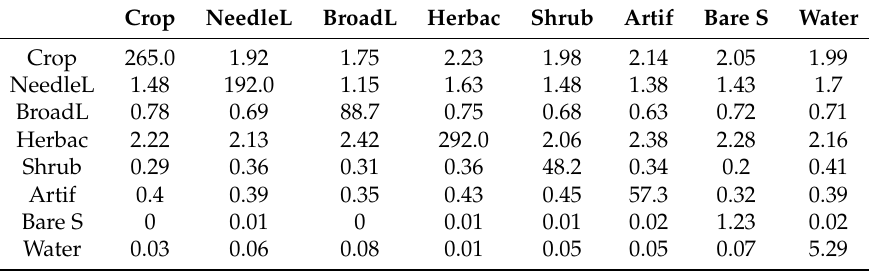
Table A9. Confusion matrix for the reference with uniform error values for each class and overall accuracy of 95%.